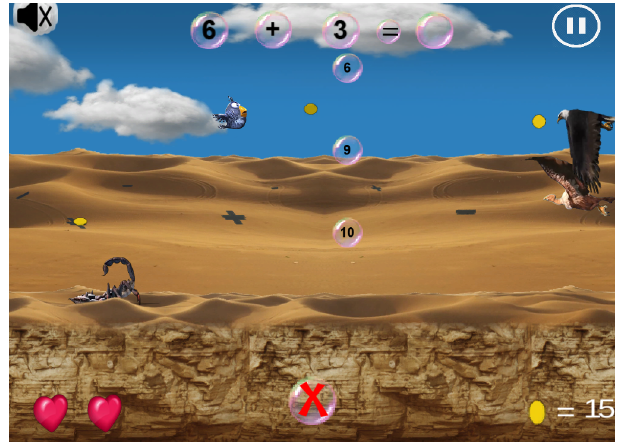
Figure 2. Finishing an operation in the first level of the game.